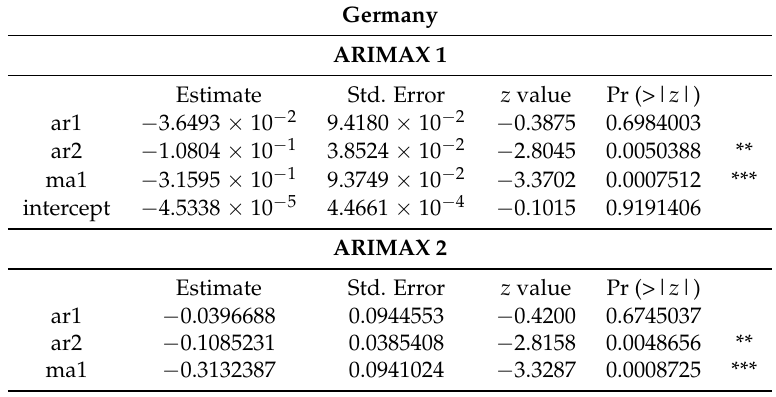
Table 16. z -test of coefficients for ARIMAX models in Germany for first difference of mean